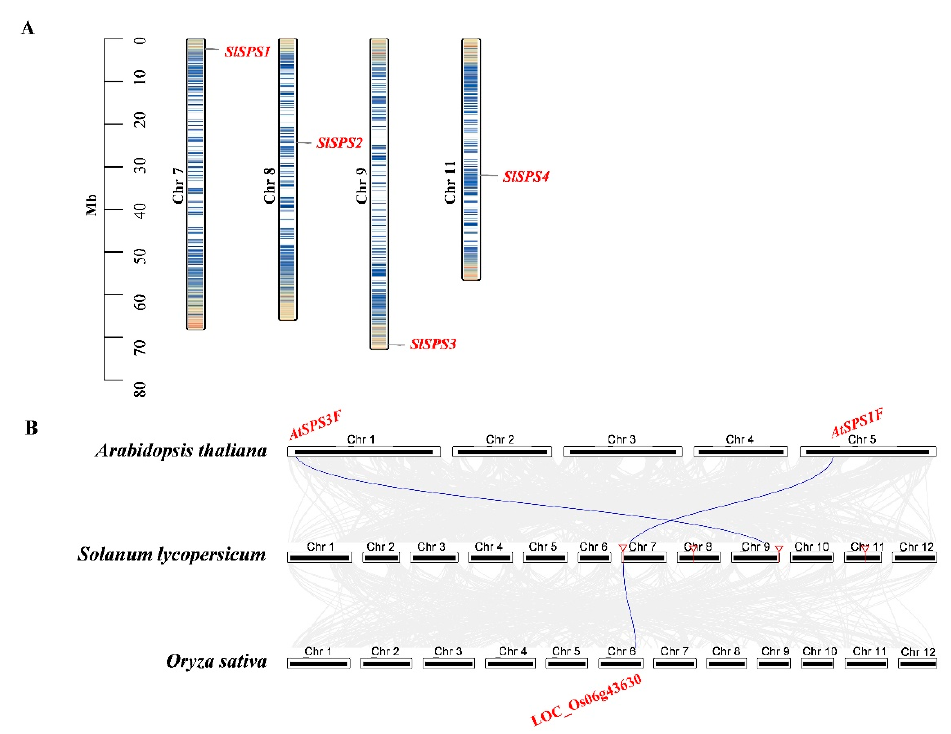
Figure 3. Chromosome localization of tomato SPS genes ( A ) and synteny analysis of SPS genes from tomato, Arabidopsis and rice ( B ). Chr, chromosome.